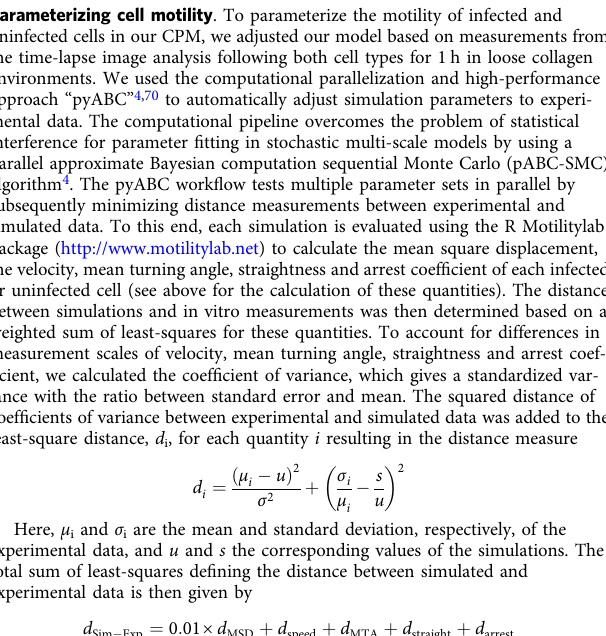
algorithm 4 . The pyABC work fl ow tests multiple parameter sets in parallel by subsequently minimizing distance measurements between experimental and simulated data. To this end, each simulation is evaluated using the R Motilitylab package (http://www.motilitylab.net) to calculate the mean square